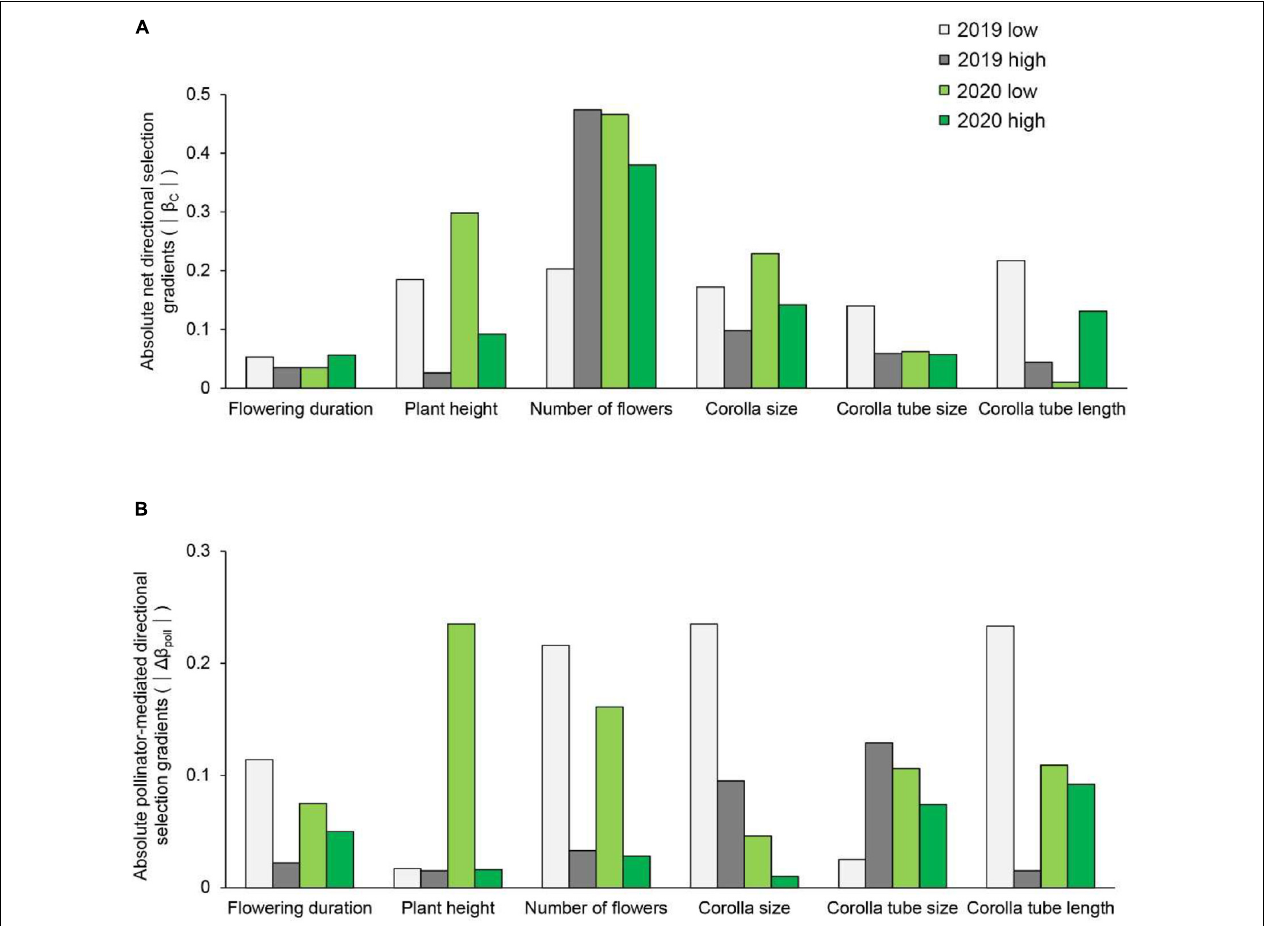
FIGURE 3 | The strength of net directional selection (A) and pollinator-mediated selection (B) on flowering duration, plant height, number of flowers, corolla size, and corolla tube size and length in Primula tibetica at two sites (low and high soil water content sites).